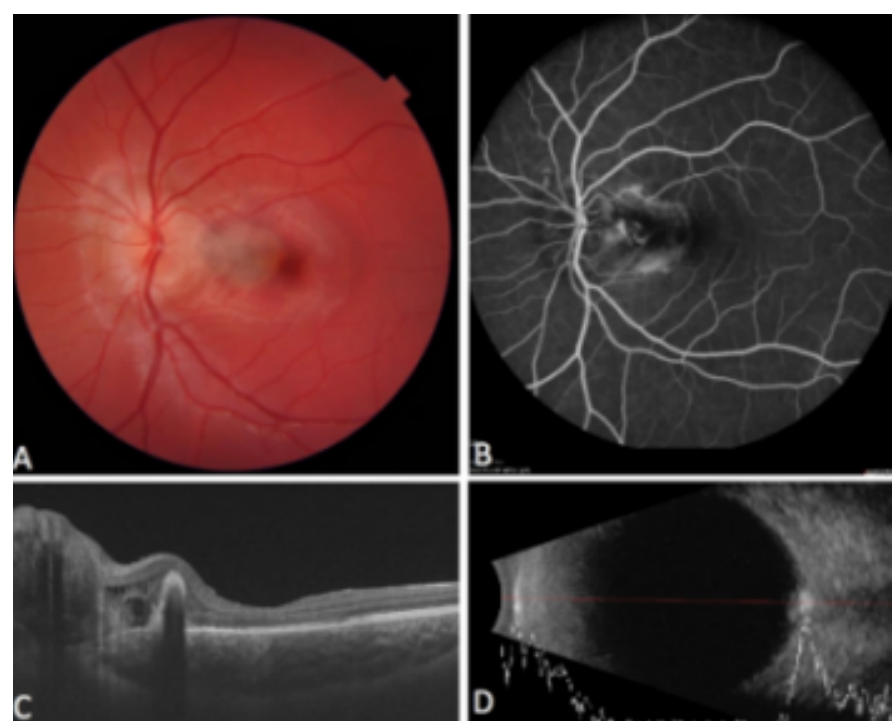
Figure 1: A) Funduscopy revealed a prominent and blurry optic disc with subretinal hemorrhage spreading towards the edge of the macula region; B) CNVM made visible through mid-phase IVFA; C) OCT scan with ODD and parapapillary cystoid edema, subretinal scarring; D) Shallow but prominent ODD are revealed through hyperreflectivity in low-gain mode using ultrasound.